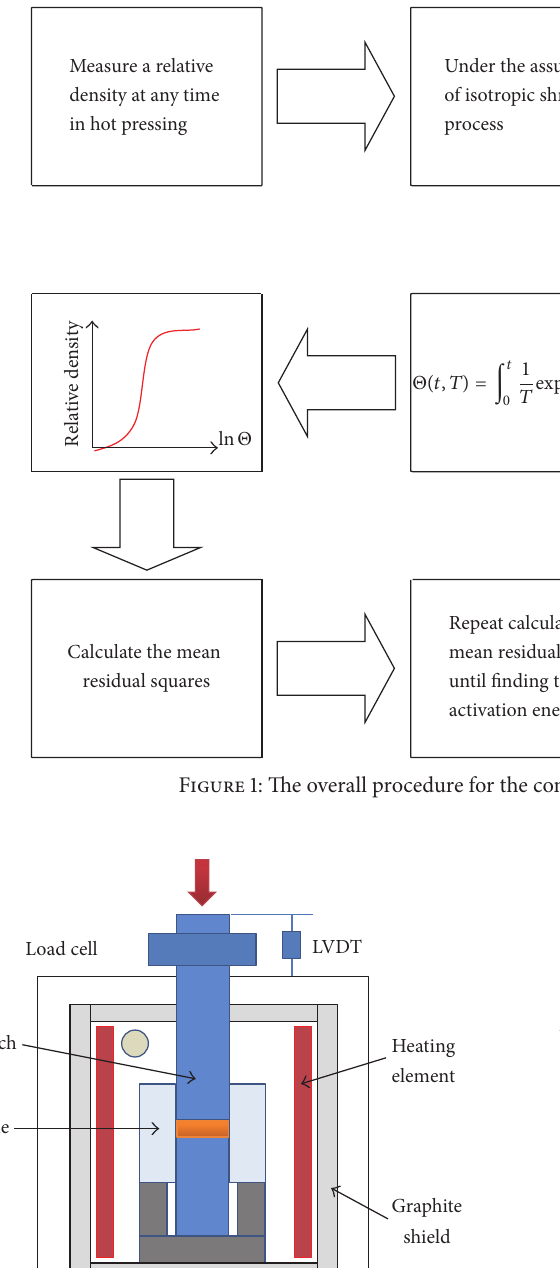
with respect to time during sintering. The densification curves, which represents the relative density changes during sintering, allow engineers to understand the characteristics of densification during sintering. Figure 3 shows various densification curves for various hot pressing